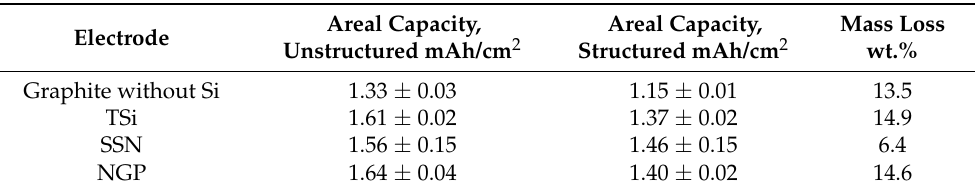
Table 5. Areal capacity and mass loss of the electrodes after manufacturing and subsequent laser structuring.